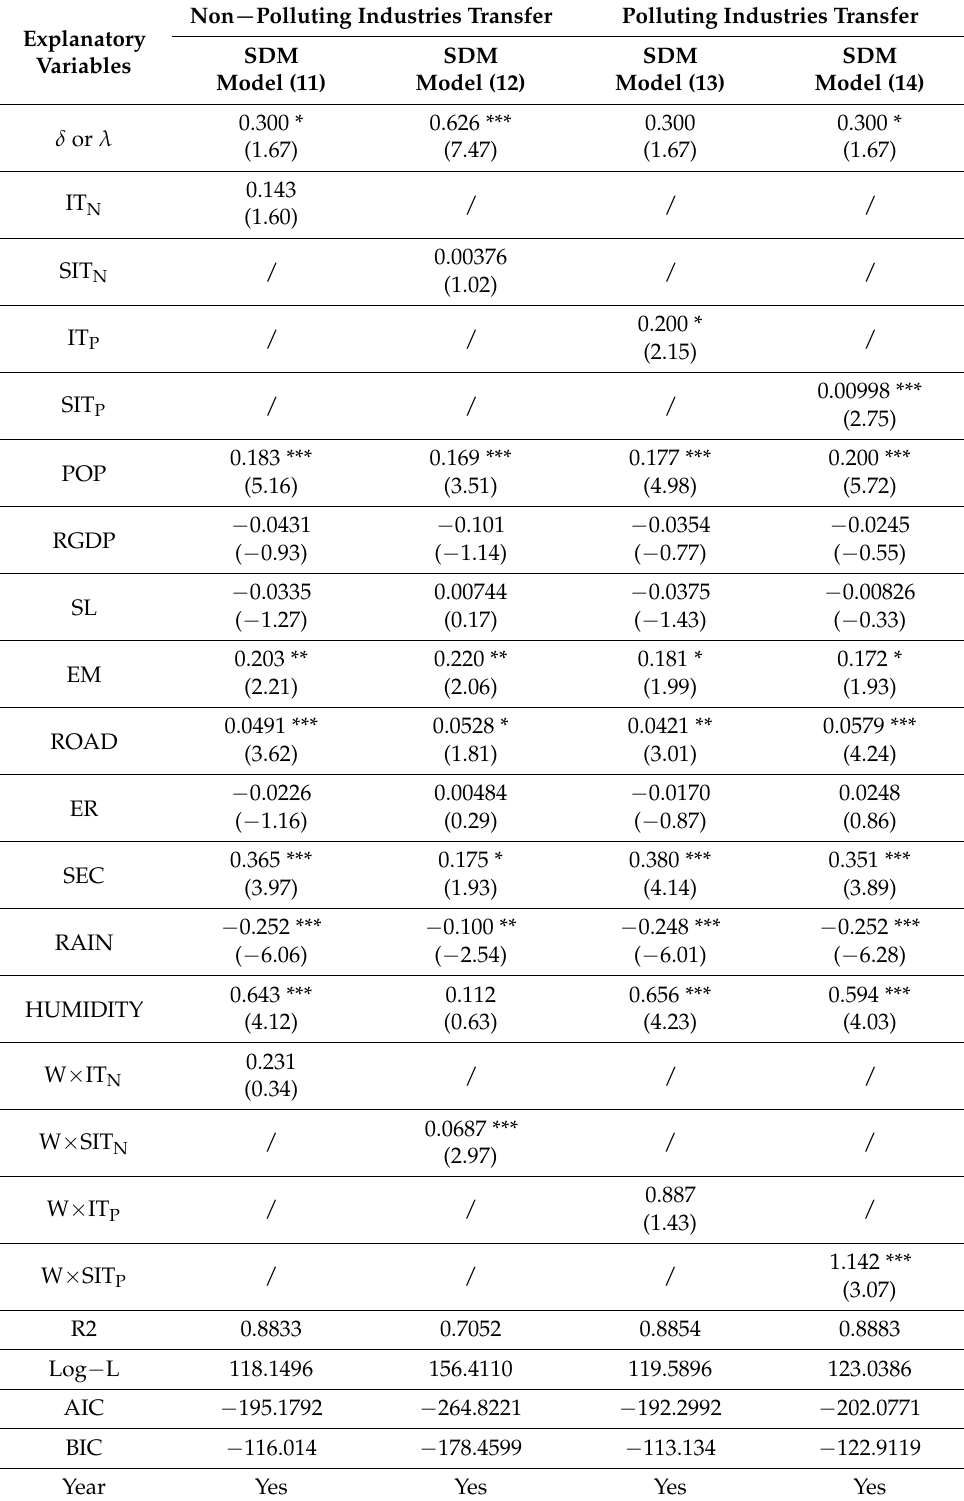
Table 8. Regression results of the impact of different industrial transfer on haze pollution. Explanatory